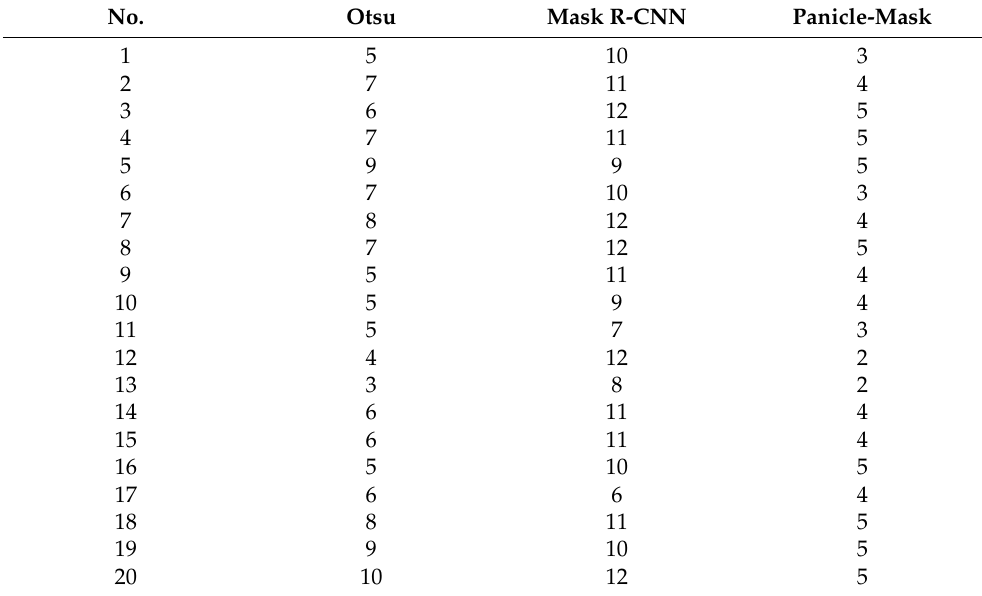
Table 3. pHash values for the different